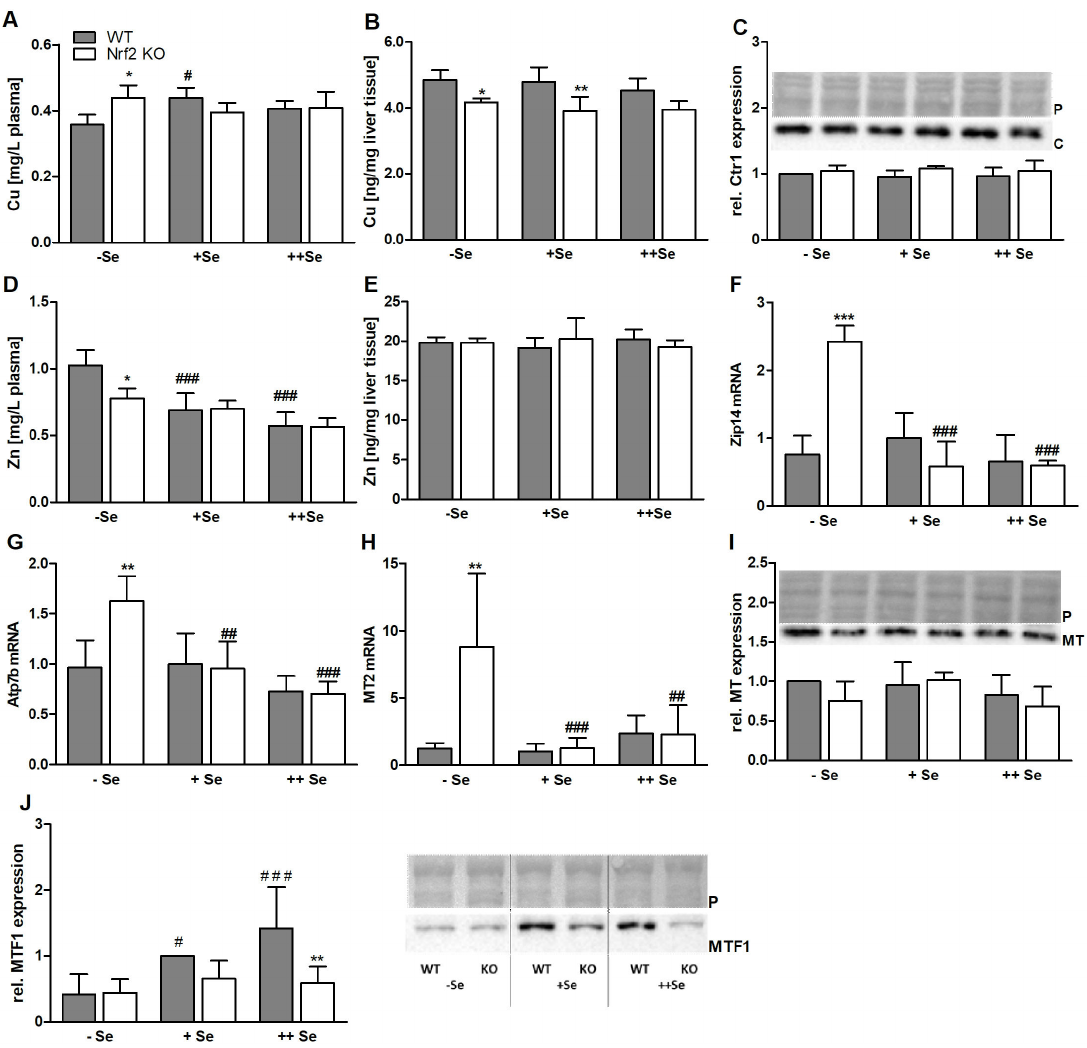
Figure 5. Biomarkers of the Cu and Zn status. Cu and Zn concentrations in the plasma ( A , C ) and liver ( B , D ) of male Nrf2 KO and WT mice fed diets with defined Se contents (–Se: 0.03 ppm; + Se: 0.15 ppm; ++ Se: 0.6 ppm), analyzed by ICP-MS / MS. Additionally, mRNA ( F – H ) and protein expression ( C , I – J ) of Cu- and Zn-related genes / proteins in the liver of these animals were determined. Western blots were normalized to the Ponceau staining (P). Bars represent means + SD ( n = 4–5). * p < 0.05; ** p < 0.01; *** p < 0.001 vs. WT and # p < 0.05; ## p < 0.01; ### p < 0.001 vs. –Se (two-way ANOVA with Bonferroni’s post-test). C =